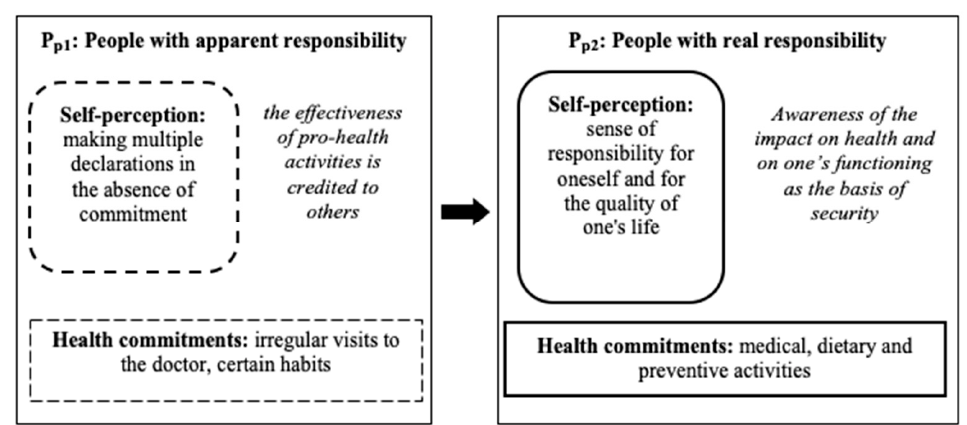
Figure 4. Two sub-models (Pp1, Pp2) showing the transformation of responsibility for one’s health from apparent responsibility to real responsibility.